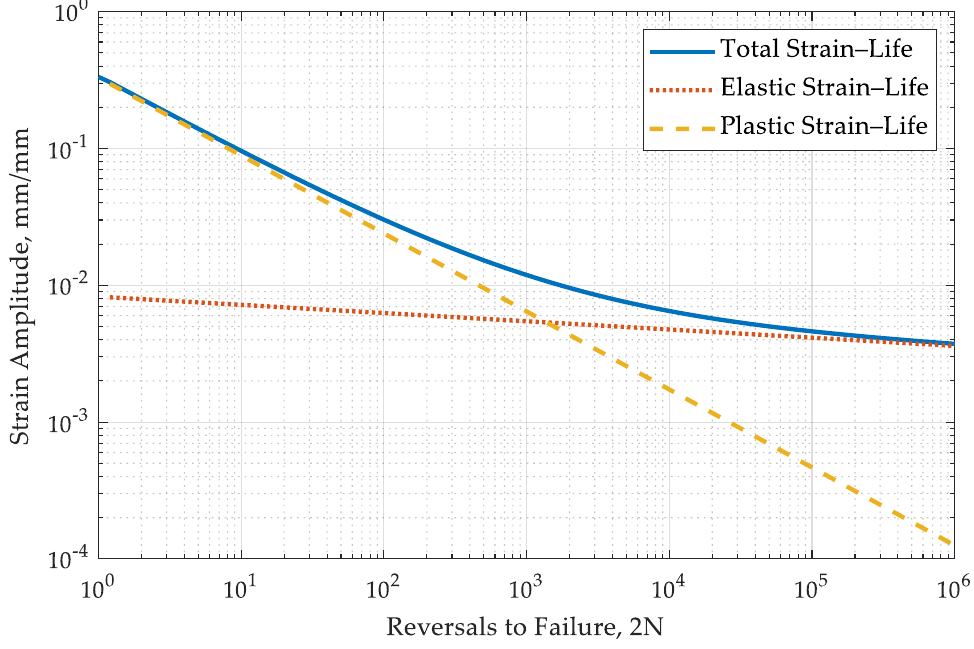
Figure 2. Strain – life curve for the EI-961 alloy (based on the Manson – Coffin – Basquin equation). Figure 2. Strain–life curve for the EI-961 alloy (based on the Manson–Co ffi n–Basquin